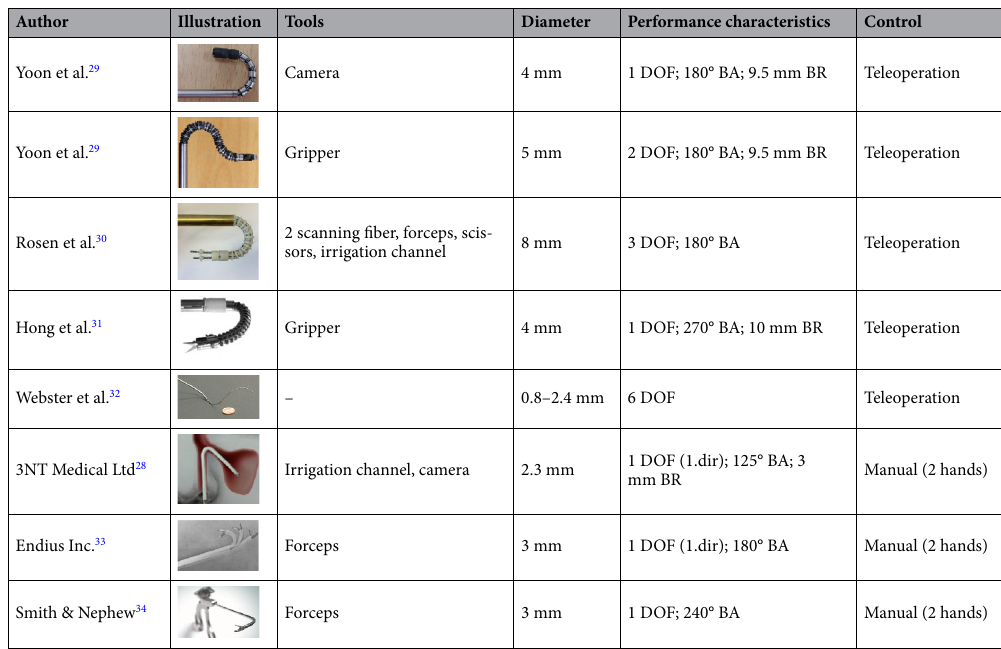
Table 1. State of the art of flexible, steerable instruments for endoscopic maxillary sinus surgery. For the performance characteristics, the number of degree of freedom (DOF), the bending angle (BA) and the bending radius (BR) of each instrument is indicated when mentioned by the